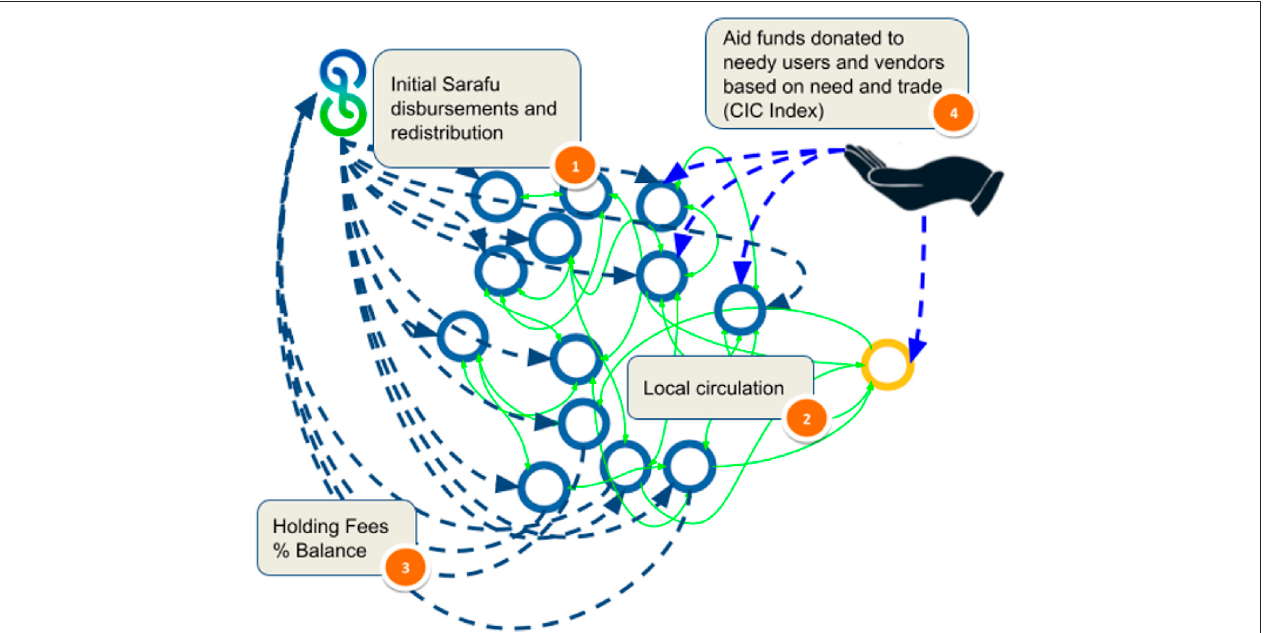
FIGURE 1 | Flow of currency in the Sarafu Network. (1) Disbursements of CIC tokens are funded by donors and humanitarian organizations. Anyone is eligible to join the network and receives 400 Sarafu ($3.60 nominal or $9.73 PPP) upon mobile registration. (2) Sarafu circulation is kick-started within the community when key hubs such as businesses and schools agree to accept the currency. New users are incentivized to join through community workshops and word of mouth. (3) Holding fees( “ negativetax ” or “ demurrage ” )encourageuserstospendtheirSarafu. (4) Donororganizationscanuseanonymizedtradedatatotargetusergroupsinneedof capacity-building e.g. female farmers, healthcare workers, teachers, etc. (Image source: Grassroots Economics, 2021).